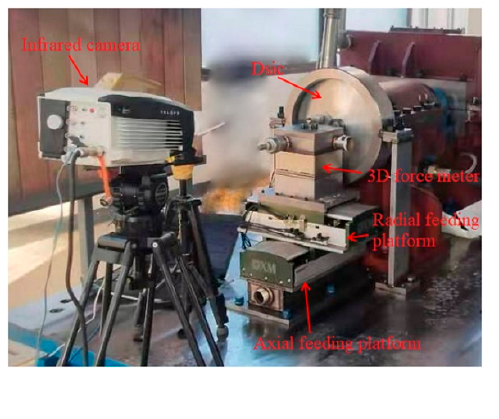
Figure 2. High-speed rotary rubbing test system.